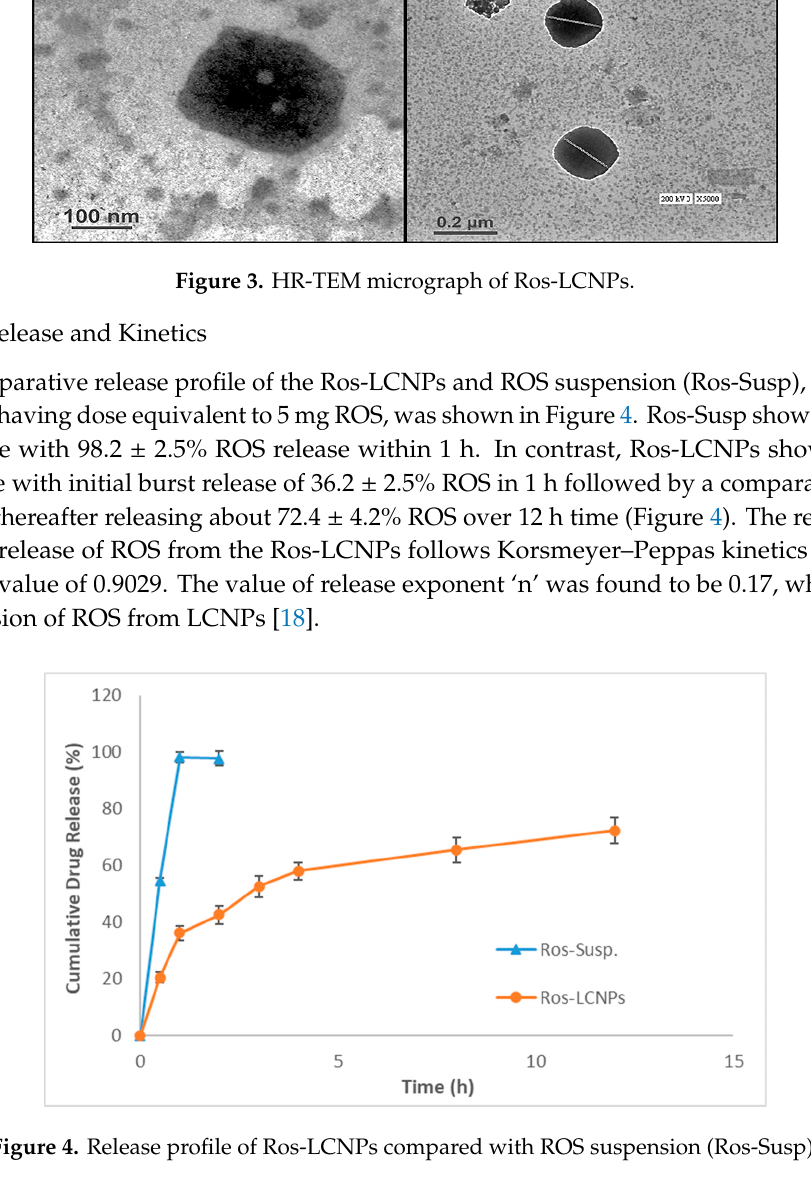
Table 2. Effect of Ros-LCNPs on PTZ-induced seizures and ICES; Data are expressed as mean ± SEM; n = 6 in each group, ANOVA followed by Tukey’s test. Treatment